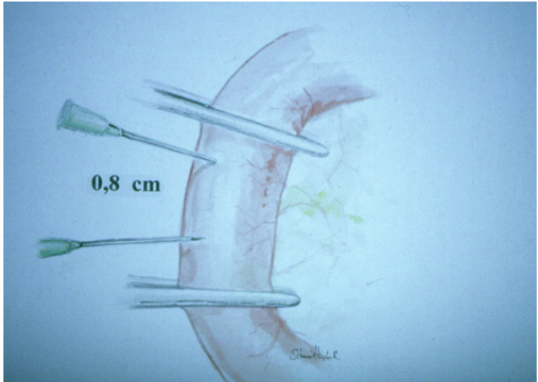
punctures on the antimesenteric border, separated by 8 mm